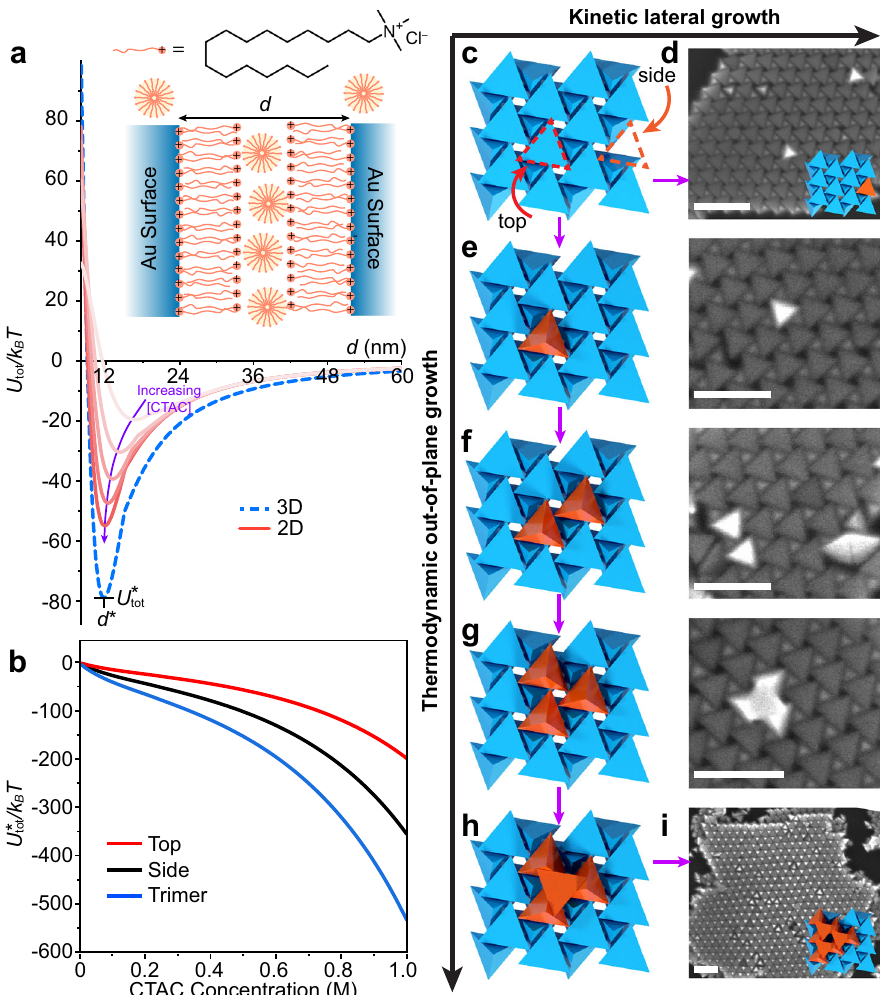
Fig. 2 Analysis of growth modes for chiral hexagonal superlattices. a Net pairwise interaction potentials for 2D and 3D chiral superlattices built from tetrahedron (Td)-shaped particles. Inset illustrates the structure of hexadecyltrimethylammonium chloride (CTAC) and its ability to form both solution- phase micelles and positively charged bilayers on Au surfaces separated by a distance, d . The x and y positions of the potential minimum as de fi ned as d * and U tot * , respectively. b Calculation of attachment energies for a single Td particle to top c , side c , and trimer g positions on a superlattice. c , d Illustration and SEM image of Td attachment at favorable side positions driving lateral (2D) growth. c , e – h Illustration and SEM images of sequential Td attachment at unfavorable monomer e , dimer f , and trimer g top positions before a favorable tetramer h can form, allowing for out-of-plane (3D) growth. i SEM image of the 3D analogue of planar chiral hexagonal superlattices generated via assembly under thermodynamic conditions. All scale bars are 100